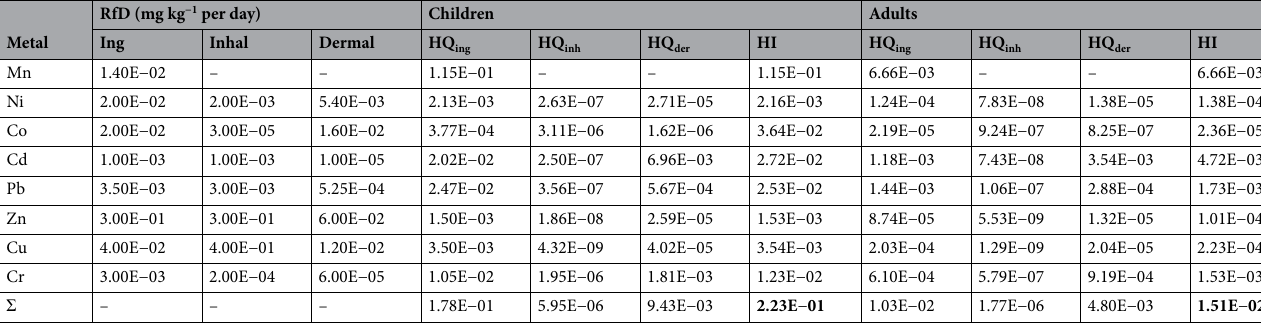
Table 7. The reference doses, hazard coefficient, and non-carcinogenic hazard index for children and adults.